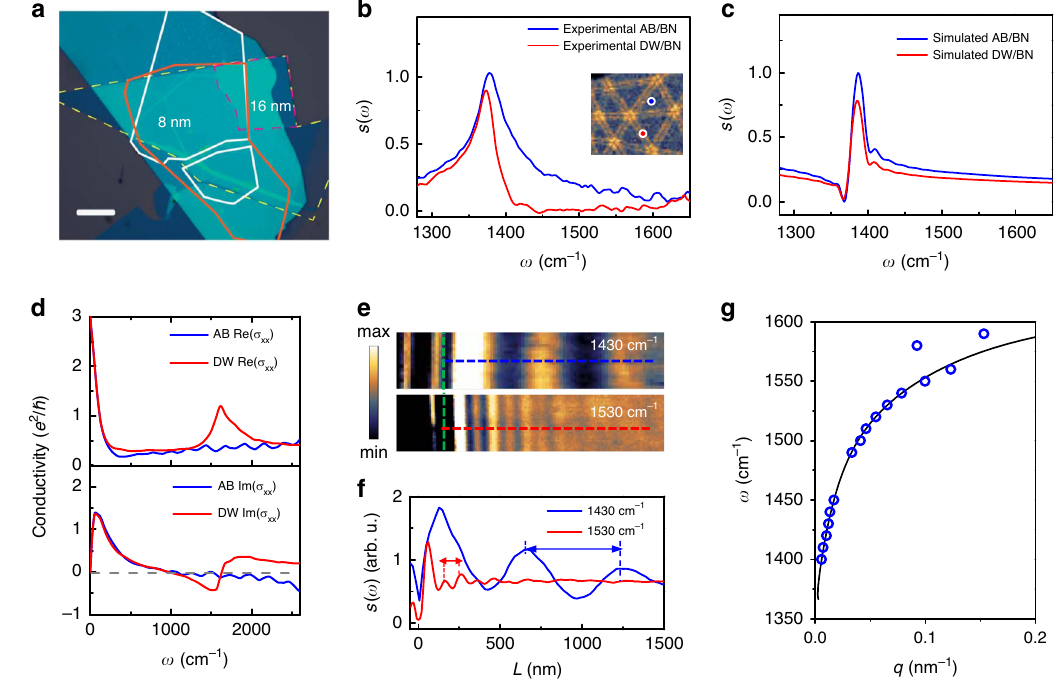
Fig. 2 Nano-FTIR spectra and phonon polariton dispersion of encapsulated TBG heterostructure. a Optical microscope image of the twisted bilayer graphene (red solid and dash) encapsulated with 8 nm (16 nm at folded region), top h-BN (yellow solid) and 20 nm bottom h-BN. Scale bar: 10 μ m. b Nano- FTIR spectra taken at AB/BA domain (blue solid line) and on the domain wall (DW) (red solid line). Inset: domain walls imaged through phonon polariton in h-BN. The blue and red dots indicate the tip locations where nano-FTIR spectra were taken at AB/BA and domain wall, respectively. Data were normalized to the signal of SiO 2 /Si substrate. c FDTD simulated spectra calculated for AB/BA domain (blue solid line) and along the domain wall (red solid line). d Tight-binding model calculated frequency dependence of the real part (top) and imaginary part (bottom) of the local conductivity σ xx for the center of the soliton regions (red solid line), and the uniform regions (blue solid line). The soliton width is 10 nm and E F = 50 meV. e Near- fi eld amplitude image of the h-BN/graphene/h-BN at frequency ω = 1430 cm − 1 (top) and ω = 1530 cm − 1 (bottom). The green dashed lines indicate the edges of the heterostructure. f Line pro fi les taken along blue and red dashed lines in e . Double arrows indicate λ p /2. g Measured dispersion relation of the phonon polariton in the heterostructure (blue circles). Black solid line is the theoretic